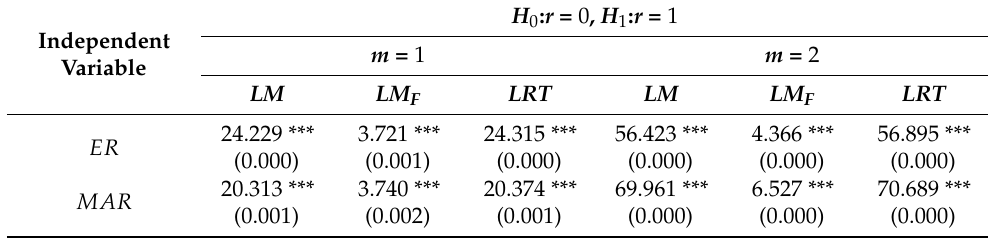
Table 2. Linearity test